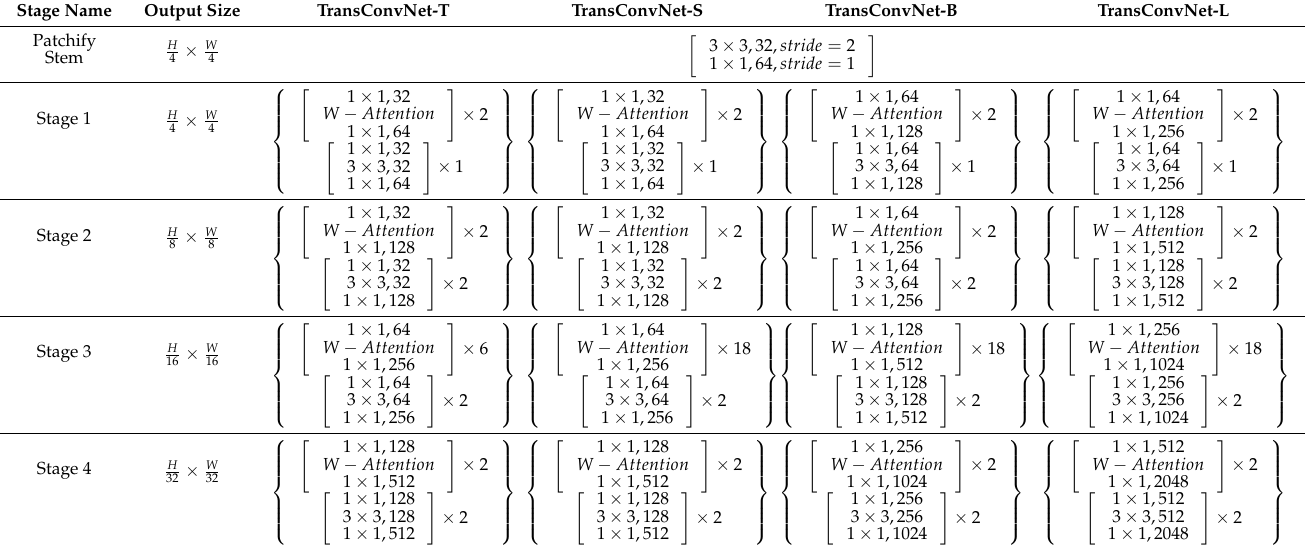
Figure 4. The structure of the spatial attention module (SAM). In our method, the output feature maps P2, P3, P4, P5, and P6 of the AFFN are re- spectively allocated with the regression range of (0, 64], (64, 128], (128, 256], (256, 512], (512, ∞ ), so that small objects are detected on low-level high-resolution feature maps, and large objects are detected on high-level low-resolution feature maps. Through the adap- tive feature fusion network, the feature maps with different resolutions balance semantic information and location information, which improves the recall and accuracy of object detection. 3.3. Multi-Task Detector Head As displayed in Figure 1, the multi-task detector head has four subtasks including classification, centerness confidence, distance offset, and angle prediction. The